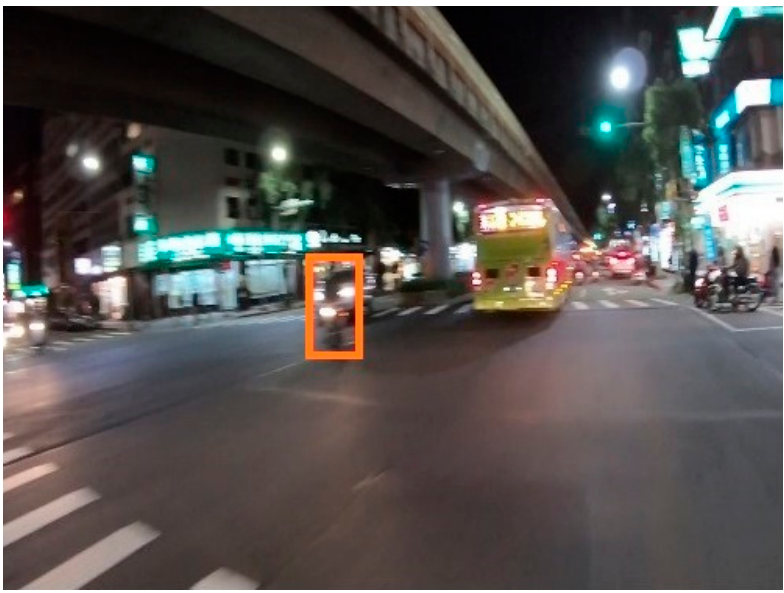
Figure 11. An example of a blurry object in a sample image.